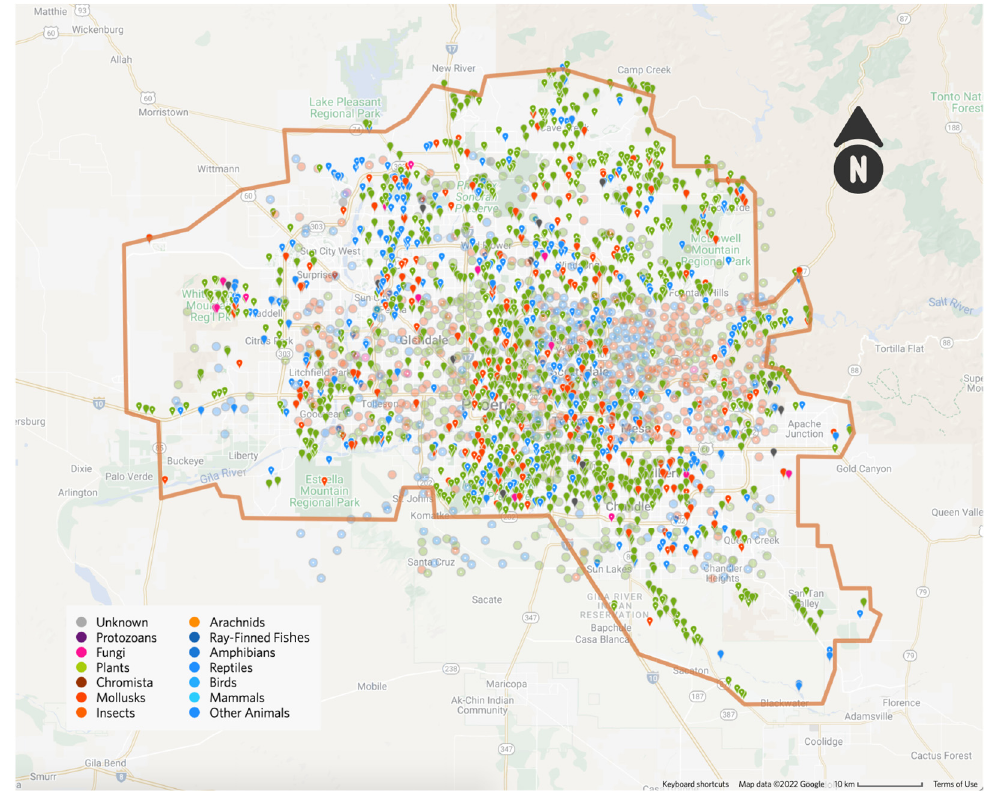
Figure 3. iNaturalist project observations within the MPE study area since February 2020 created using iNaturalist and Google Maps data.